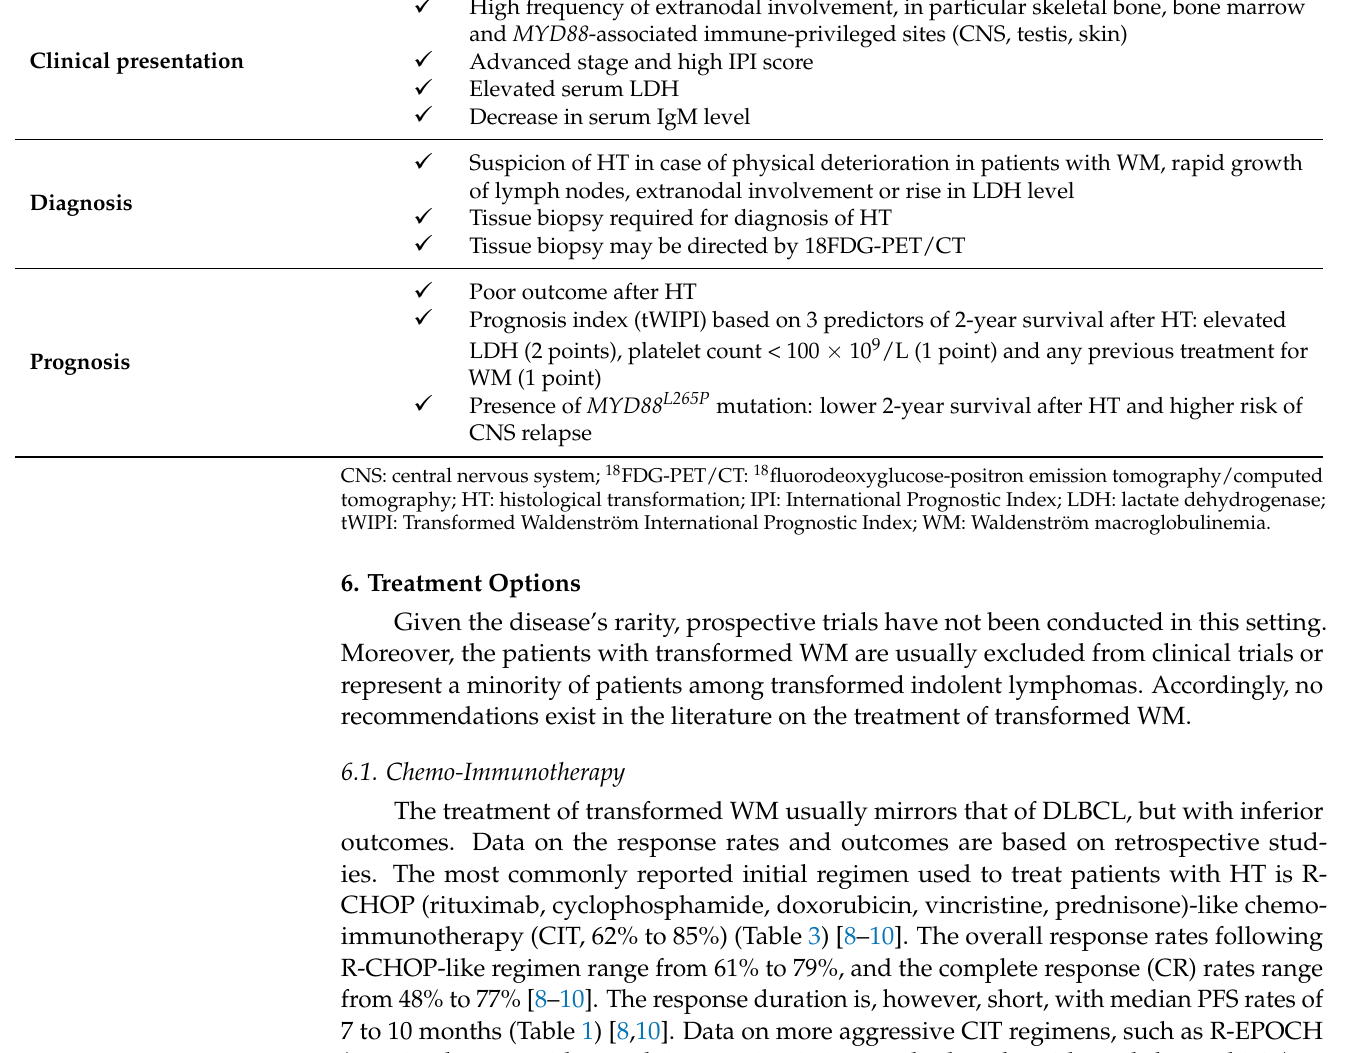
Table 2. Key points on clinical presentation, diagnosis and prognosis of HT in WM.